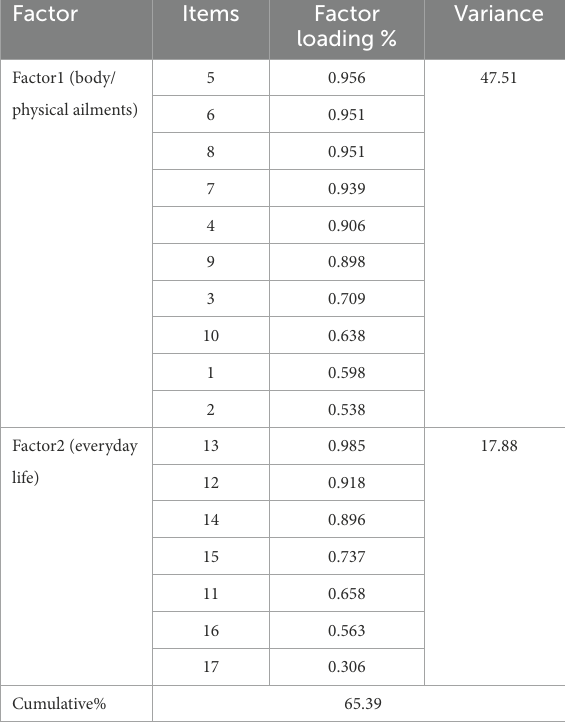
TABLE 2 Exploratory factor analysis of the Farsi version of the wound- QOL. Factor